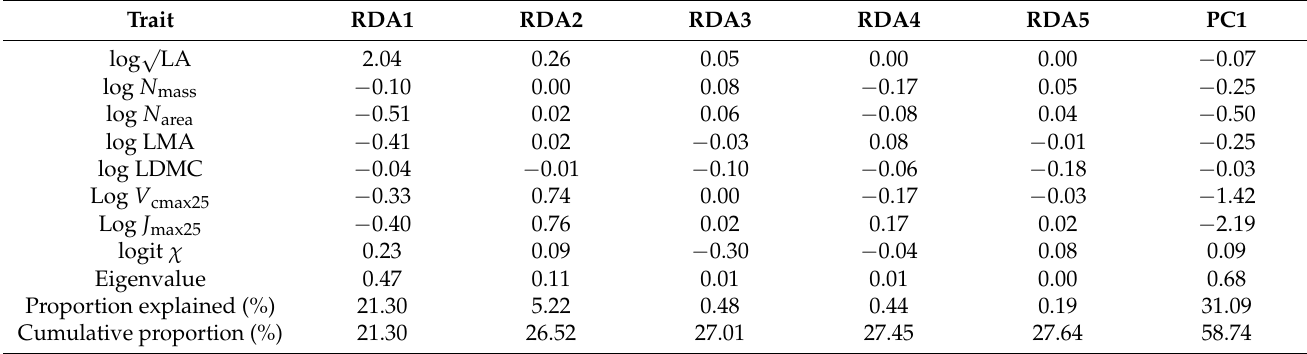
Table A2. Description of families with a record number greater than 8.